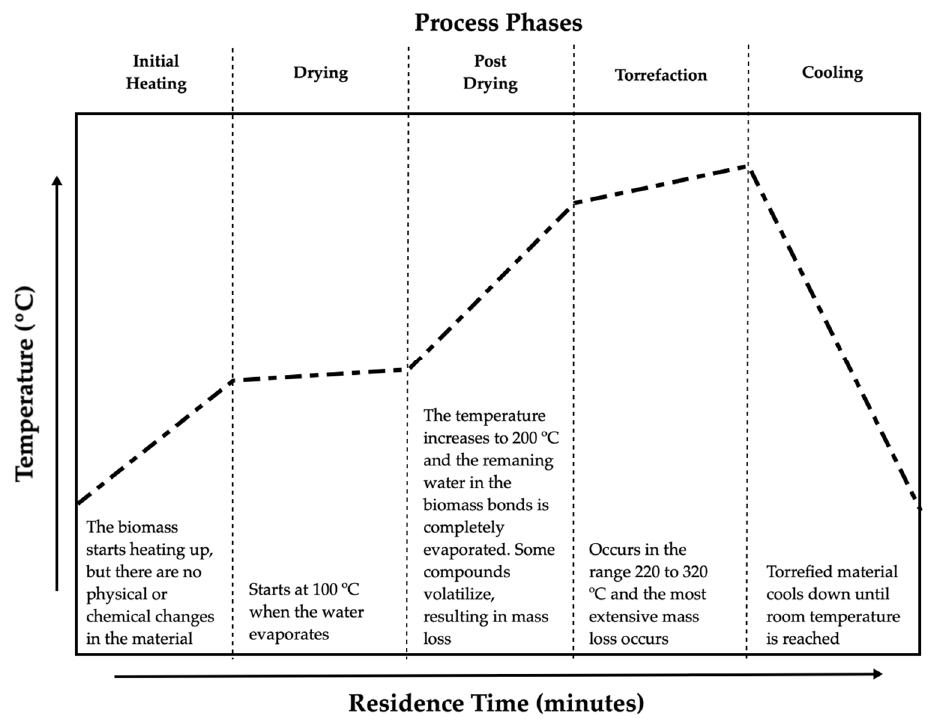
Figure 1. Process phases (adapted from [14] ).